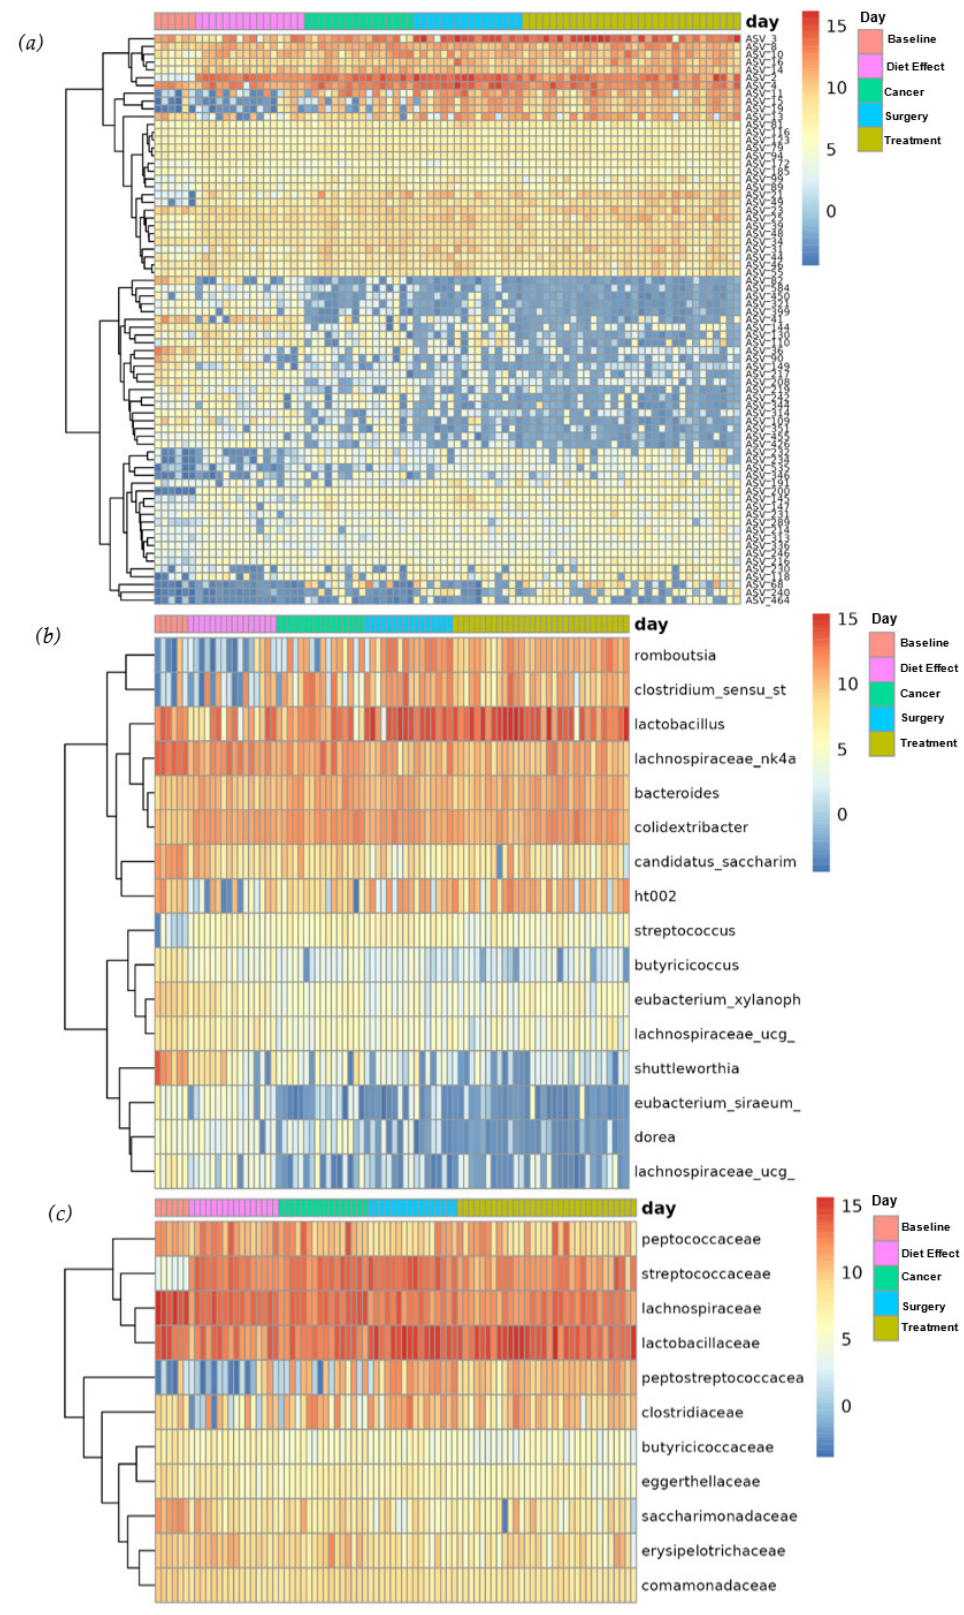
Figure 5. ( a ) Abundance heatmap of ASVs by day; ( b ) abundance heatmap of genera by day; ( c ) abundance heatmap of families by day. Only features with an adjusted p -value below 0.1 are shown.